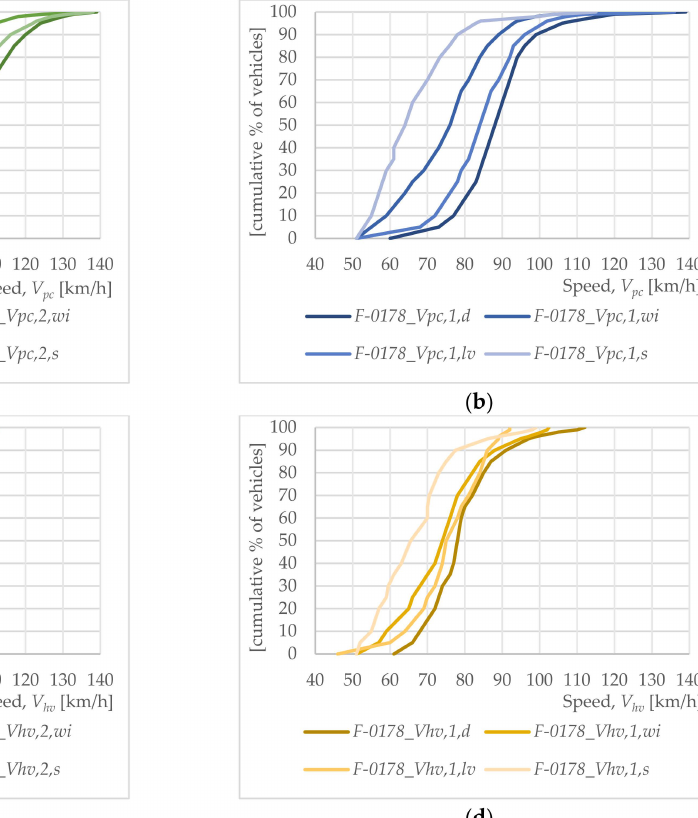
Figure 3. Empirical speed distribution functions for different weather conditions at test site 0178: ( a ) passenger cars in lane 2; ( b ) passenger cars in lane 1; ( c ) heavy vehicles in lane 2; ( d ) heavy vehicles in lane 1.